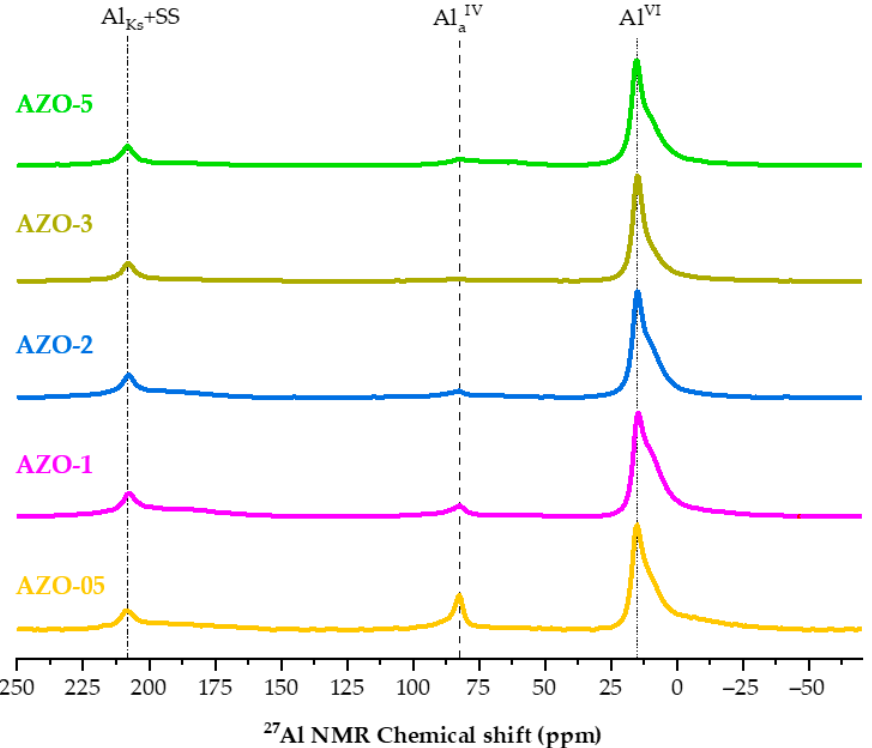
Figure 3. 27 Al MAS NMR of AZO quasi − spherical nanoparticles as − prepared with a different nomi- nal aluminum content. The lines highlight the peaks assigned to the 6 − fold coordinated aluminum, Al VI , 4 − fold coordinated aluminum, Al aIV and a spinning − side band (SS) of the octahedral signal also containing a Knight − shift signal, Al Ks + SS.